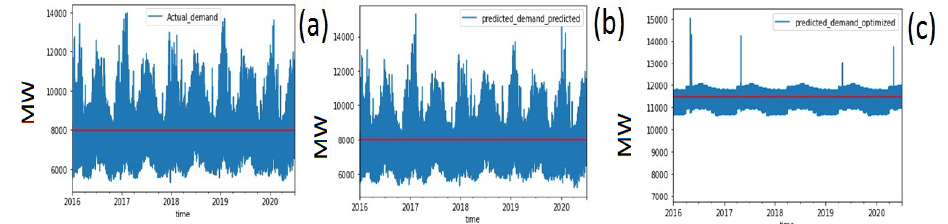
Figure 4. Predicted demand by Controlled and Uncontrolled